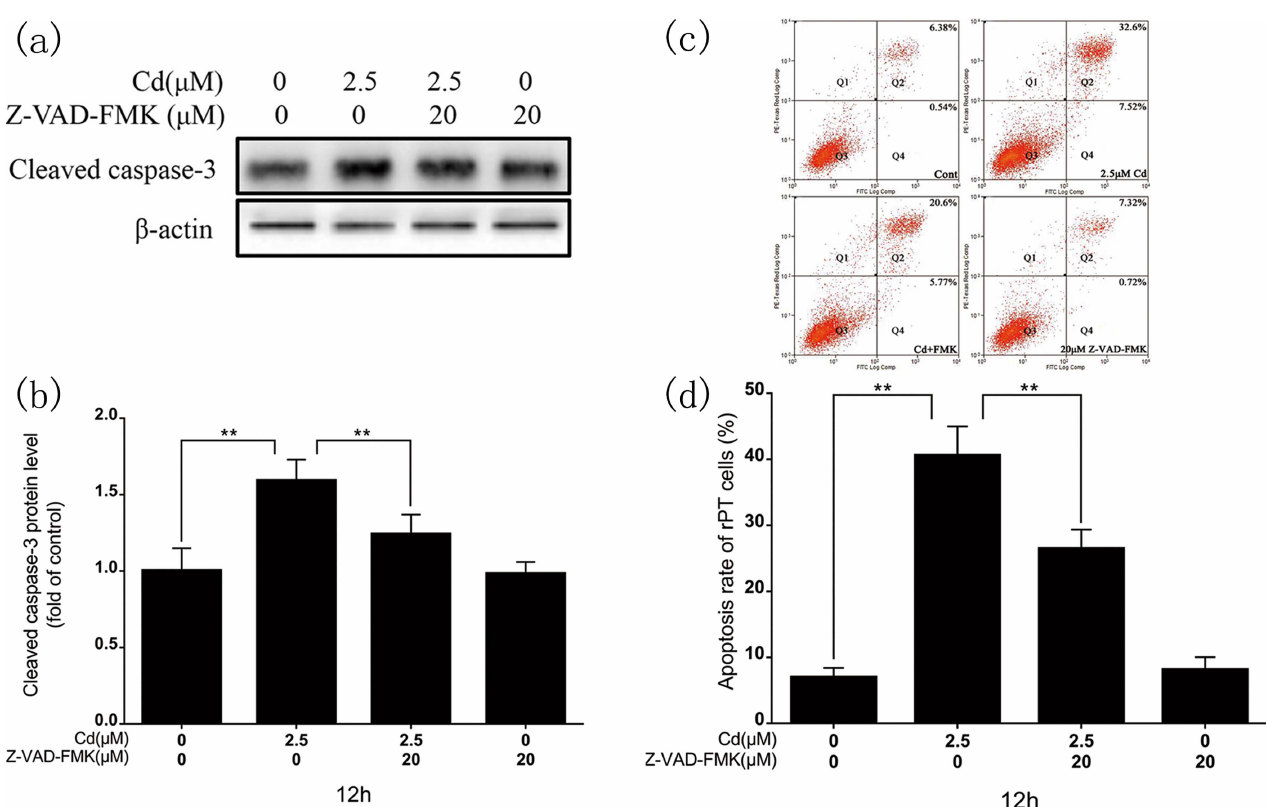
Fig 5. Effects of Z-VAD-FMK on cadmium-induced rPT cell apoptosis. (a) Representative images of cleavedcaspase-3western blot after 12-h cadmium treatment in the absenceor presence of Z-VAD-FMK. (b) Quantitative analysisof cleavedcaspase-3;grayscaleof the control was set at 1. (c) Flow cytometry assessment of the rPT cell apoptosisrate after 12-h cadmium treatment with/without Z-VAD-FMK. (d) Percentageof apoptotic cells. Results are expressed as the mean ± SD of three separate experiments, each performed in triplicate (n = 9). ** P < 0.01 as compared to